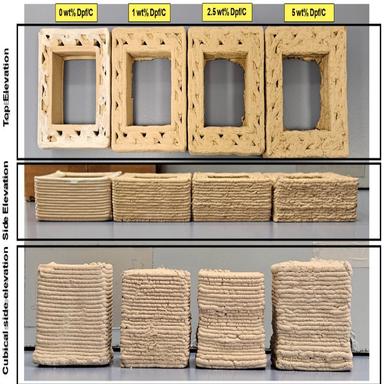
Top and side elevation of four-walled structure with 25,50 and 75% along with 50 × 50 mm with 100% infill cubes with different Dpf/C ratios.